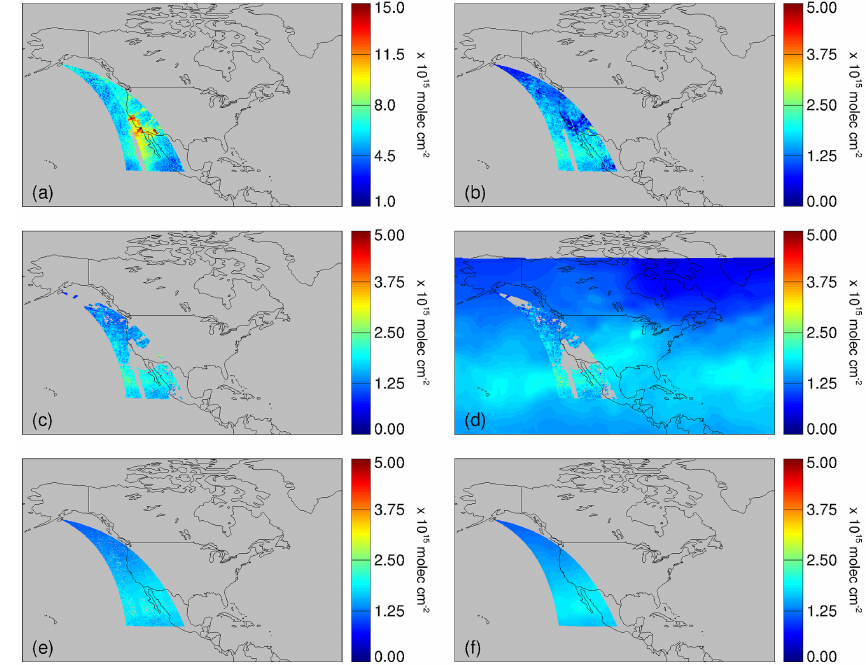
Figure 4. Calculation of the stratospheric NO 2 estimate on 15 January 2007, using OMI observations from within the anticipated TEMPO field of regard at 23:30UTC (15:30Pacific Standard Time): (a) slant columns at 0 . 1 ◦ × 0 . 1 ◦ resolution. (b) Initial stratospheric estimate ( V init ) resulting from Eq. (2). (c) Masked V init using a threshold of S trop /A strat < 0 . 3 × 10 15 moleculescm − 2 to remove large tropospheric influence. (d) Adding context outside of the available TEMPO field of regard by using independent low-Earth-orbit observations from GOME-2 that have been corrected for time of day. (e) Stratospheric NO 2 estimate with masked areas interpolated and smoothed. (f) Final stratospheric NO 2 estimate after hot spot removal and smoothing.